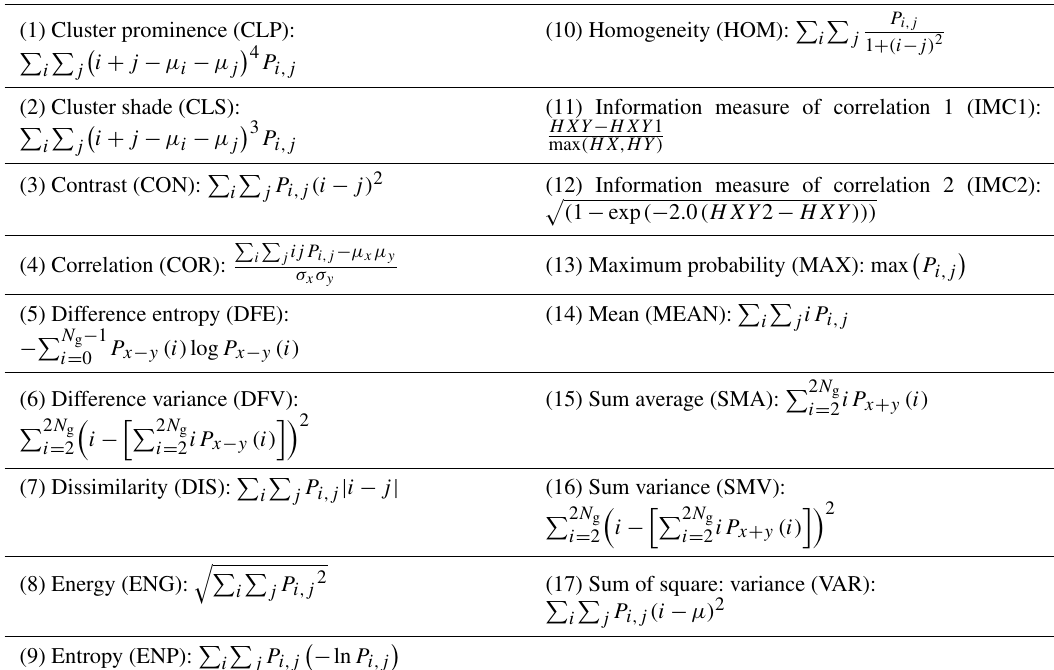
Table 2. GLCM texture measures analyzed in this study, where P i,j is the (i,j) th entry in the GLCM; (cid:80) i is (cid:80) (cid:80) N g ; N g is the number of distinct gray levels in the quantized image; P x + y (k) = (cid:80) j = 1 N g (cid:80) N g P x − y (k) = (cid:80) P i,j ( | i − j | = k ; k = 0 , 1 ,...,N g − 1); P x (i) = (cid:80) i = 1 j = 1 means and standard deviations of P x and P y ; HXY = − (cid:80) i (cid:80) j P i,j log P i,j ; HXY 1 = − (cid:80) i (cid:80) j P i,j log p x (i)p y (j) ; HXY 2 = −